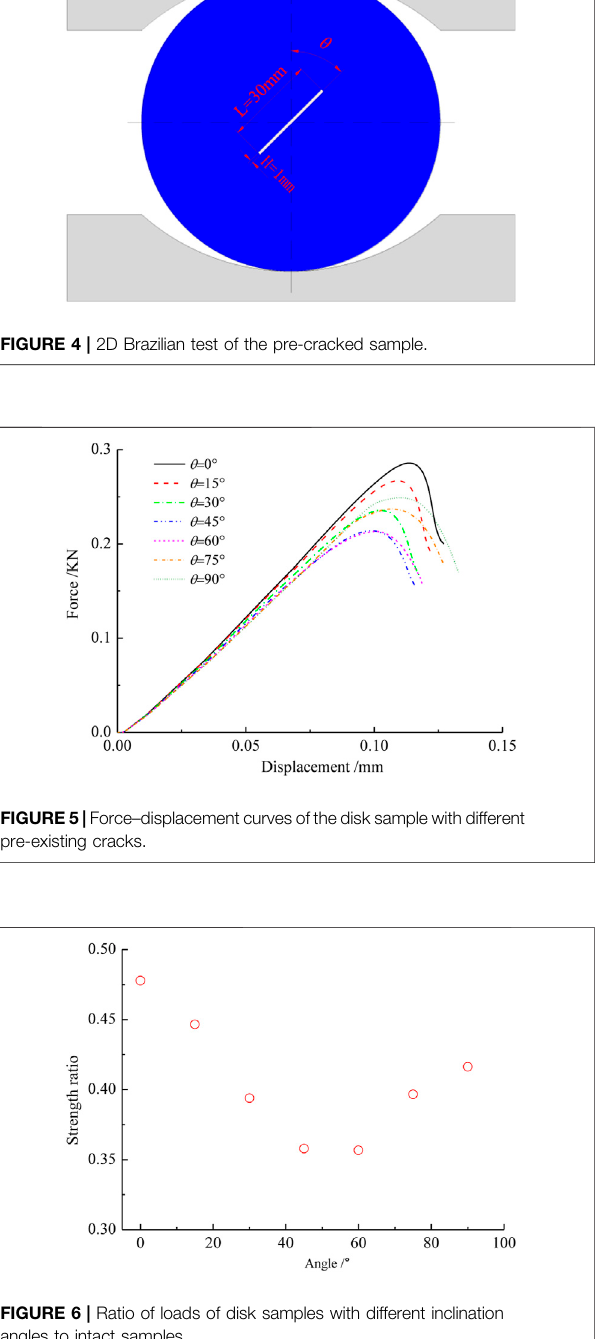
sample, ranging for 0 to 90 with an increment of 15, as shown in Figure 4 . The length and width of cracks are, respectively, L (cid:2) 30 mm and H (cid:2) 1 mm. The PFD simulation of the Brazilian test of the fi ssure sample is performed by taking the same model parameters in Section 3 .